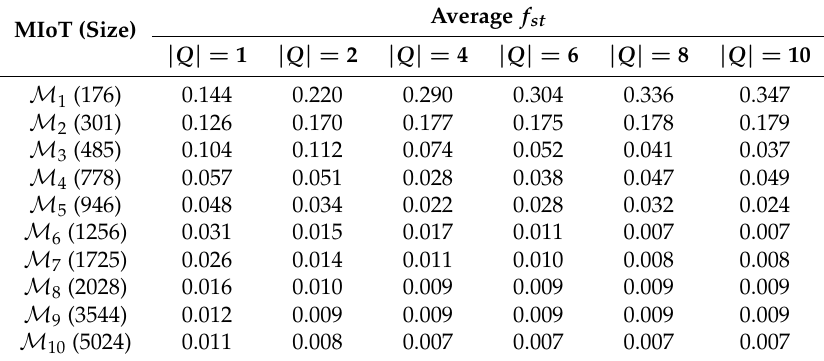
Table 10. Average values of f st against the size of MIoTs and queries used to generate the virtual IoTs (supervised approach).